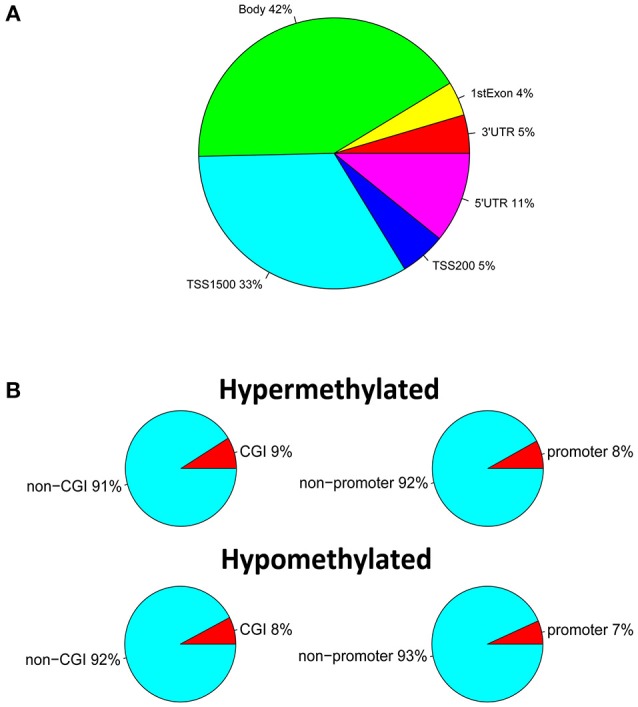
Identification of DNA methylation differences between SO and OA. (A) Genomic distribution of differentially methylated probes regarding their respective location to genes. (B) Proportions of hypermethylated and hypomethylated probes from genes with associated CpG islands (CGI) and probe locations, categorized as promoter (±1 kb from TSS) or non-promoter regions.